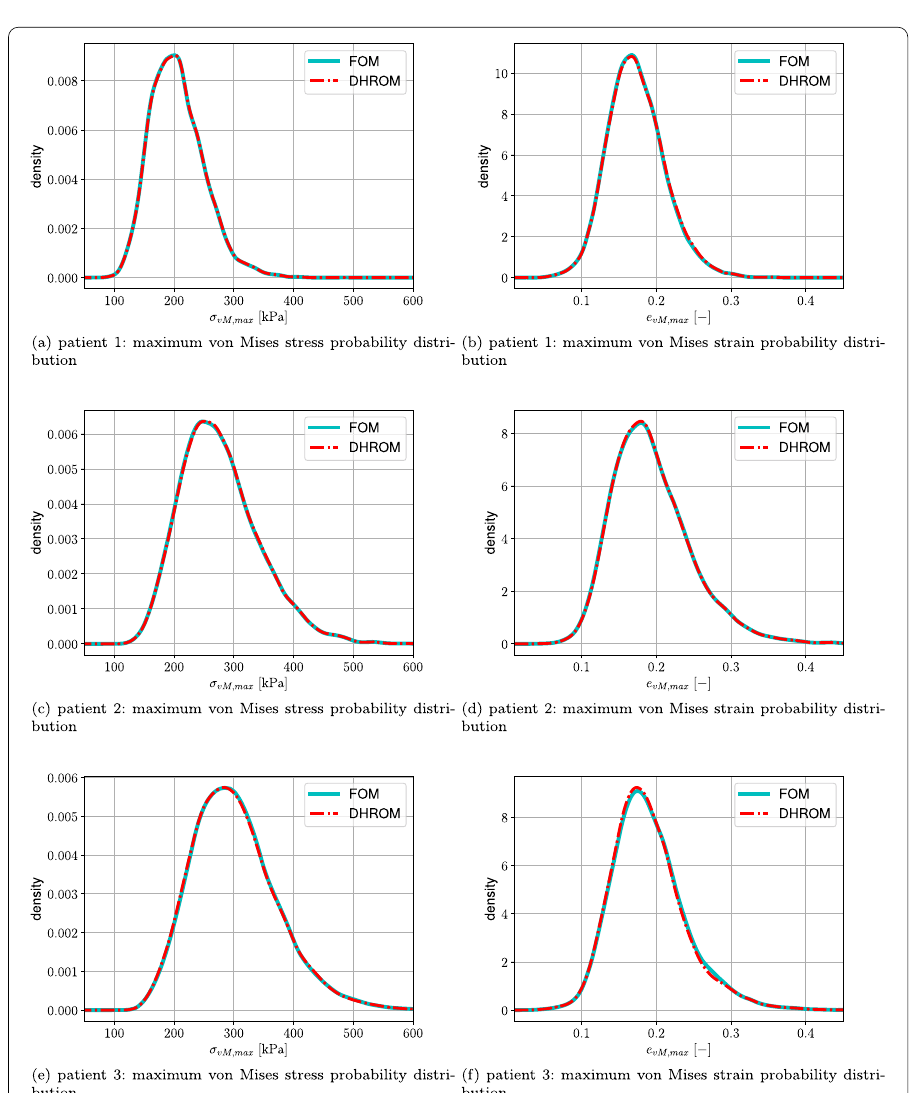
Fig. 14 Kernel-density-estimated (Gaussian kernel) probability distributions based on FOM and DHROM evaluation of 10,000 identical (per patient) parametric configurations. The quantities of interest are the maximum von Mises stress as well as the maximum von Mises strain in the aortic wall